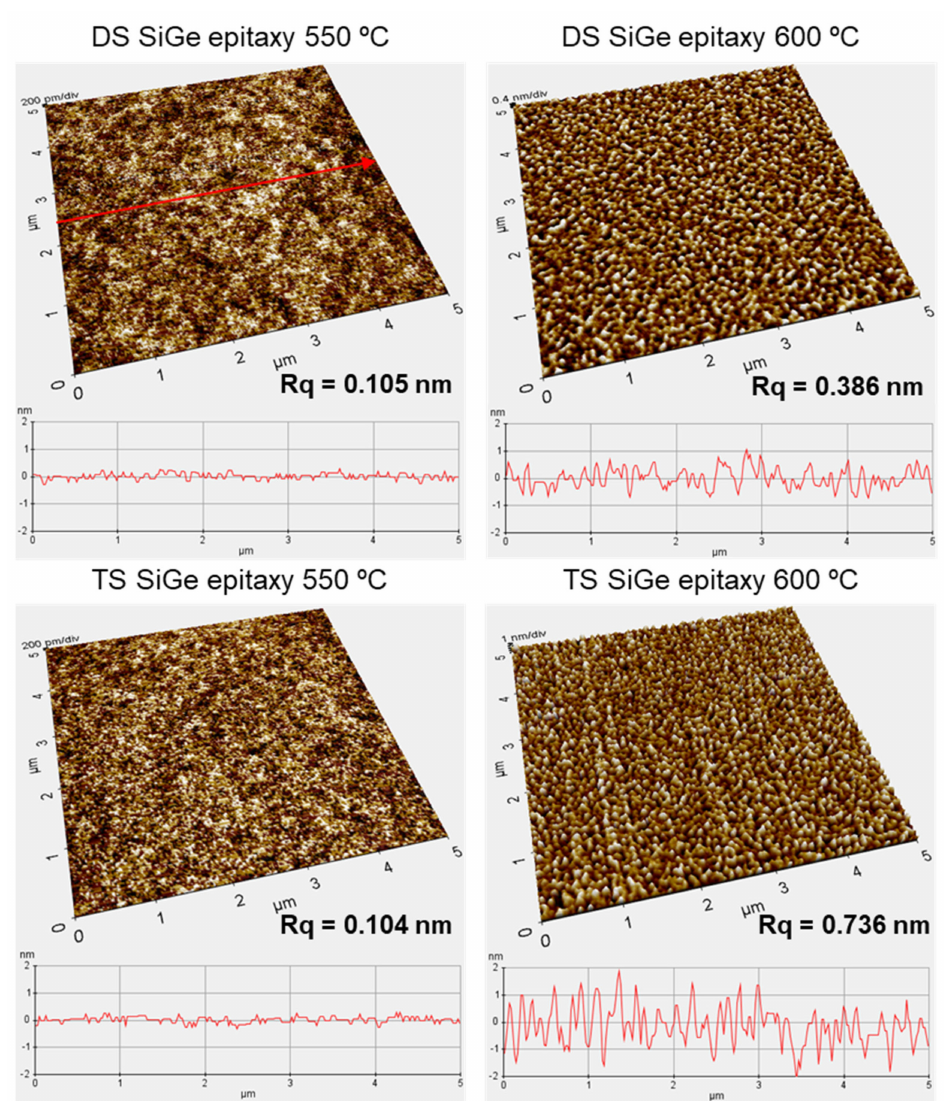
Figure 7. AFM measurements and RMS surface roughness (Rq) values of the SiGe epilayers grown under UHVCVD conditions at 550 and 600 ◦ C using disilane (DS) and trisilane (TS). The flow rates of disilane, trisilane, and germane are 20, 5, and 30 sccm, respectively. The red lines represent the results of the line scans and their positions. All line scans were performed at the same